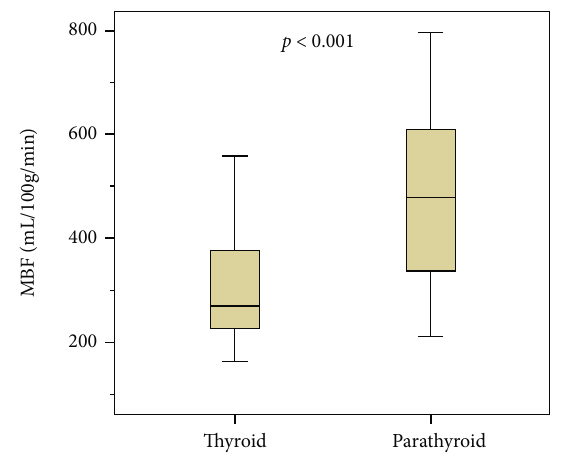
Figure 1: Boxplot. BF normal thyroid tissue vs BF parathyroid adenomas.